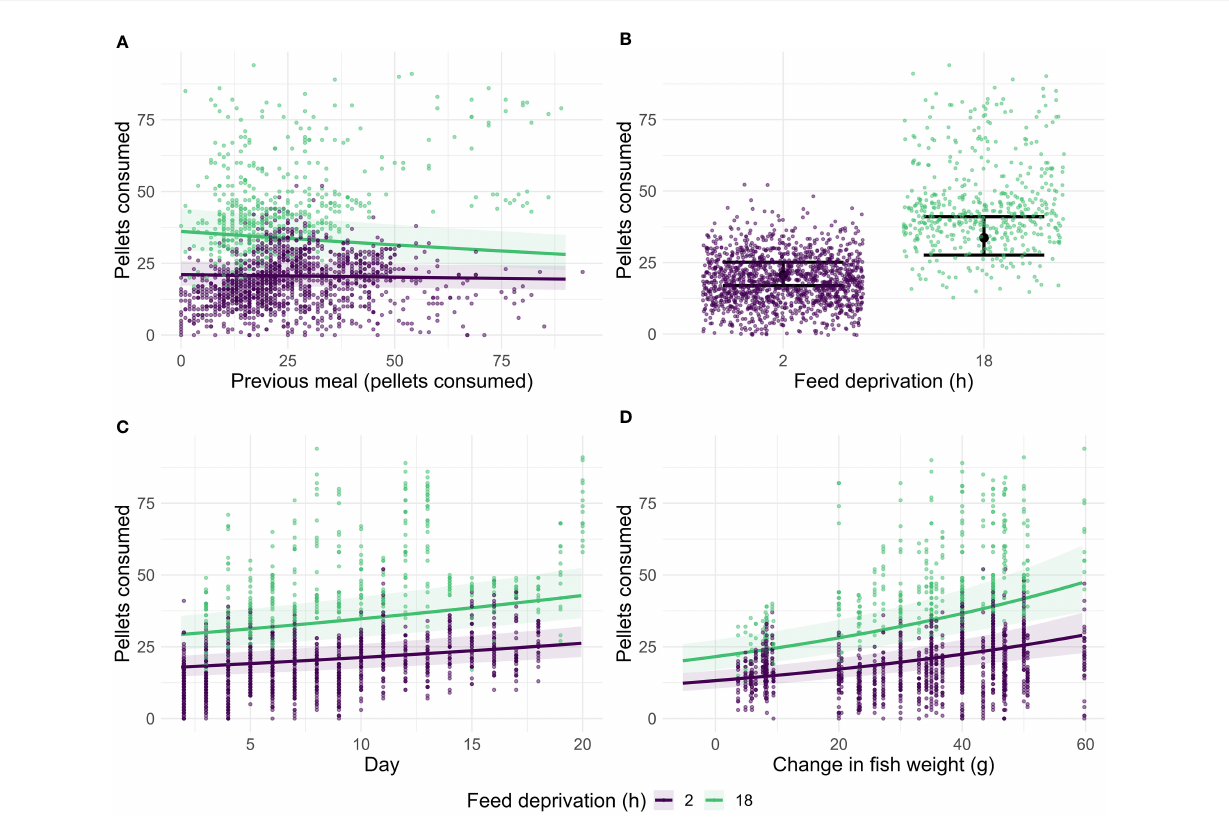
FIGURE 2 Number of pellets consumed in relation to pellets consumed in previous meal and the feed deprivation time, 2 or ≥ 18 h (A) , number of pellets consumed in relation to feed deprivation time (B) , number of pellets consumed in relation to the day of experiment and feed deprivation time (C) , and number of pellets consumed in relation to the fi sh weight change ( fi nal minus initial weight) and feed deprivation time (D) . Lines and shaded areas show effect and 95% con fi dence intervals of each variable predicted by a linear mixed effect model, dots represent measurements by fi sh, meal, and feed deprivation time